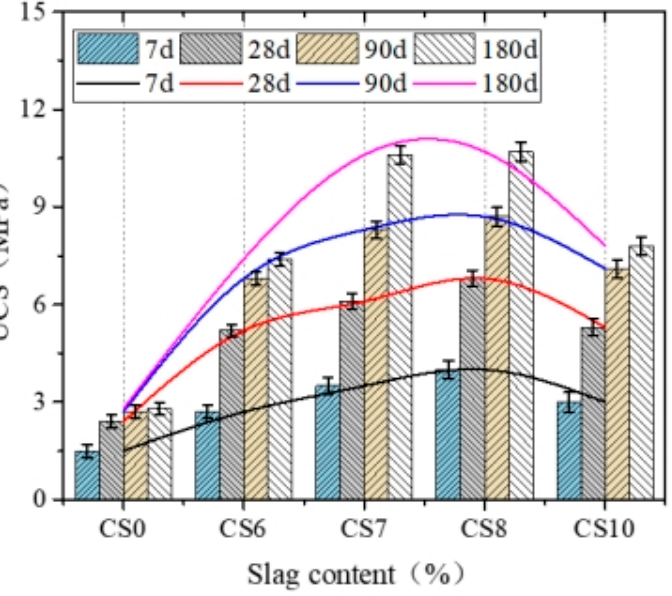
Figure 5. Effect of CFBS content on the UCS of cement-stabilized clay. The error bars represent the standard deviation of the test results for five samples.